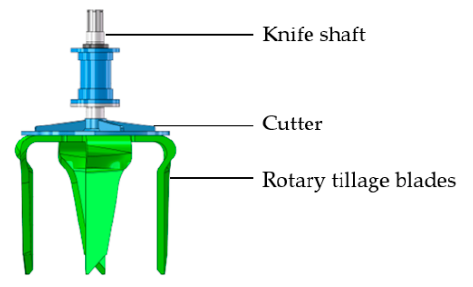
Figure 2. Vertical rotary tiller.